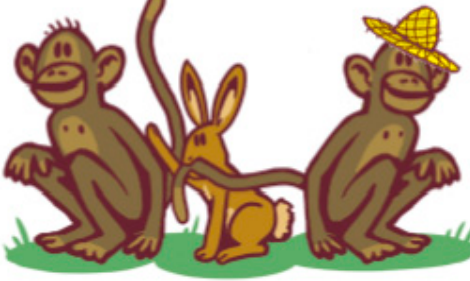
Figure 4. Picture paired with test item 7.